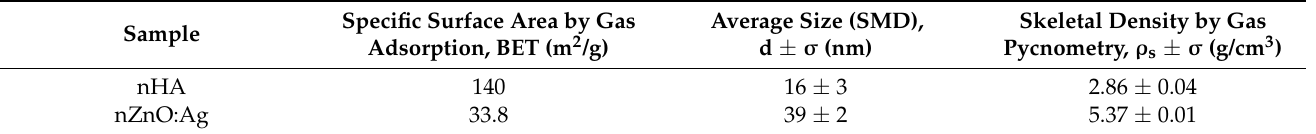
Table 1. Parameters of the